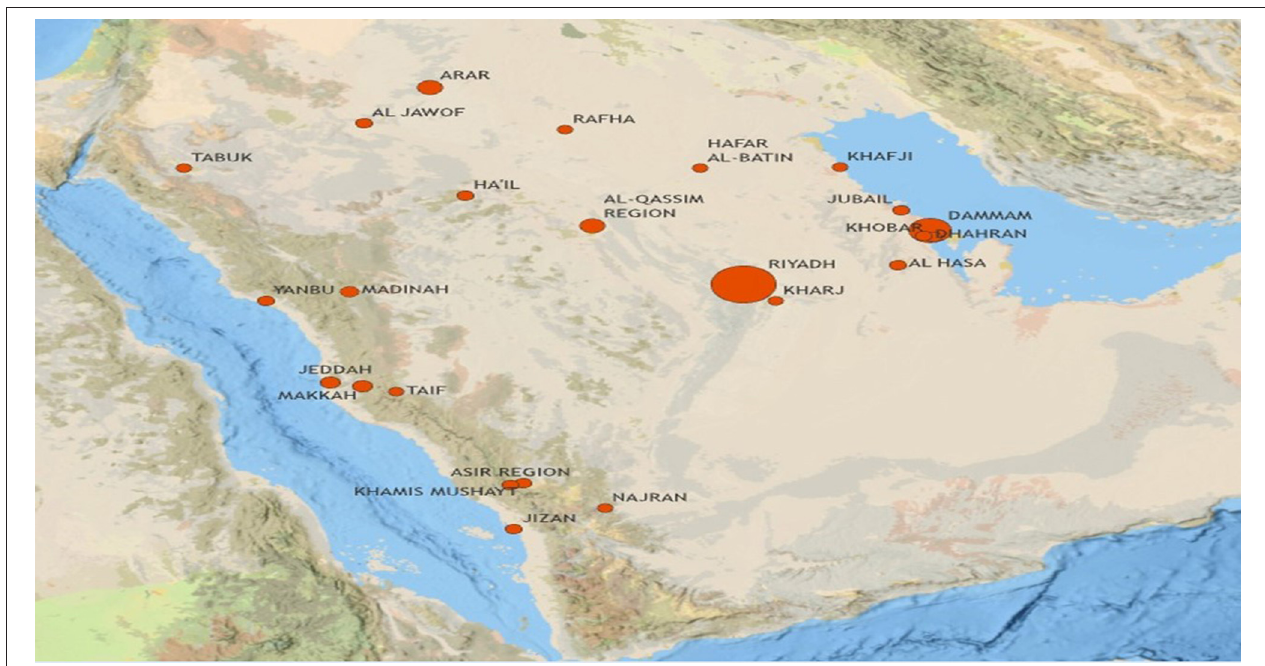
FIGURE 1 | Distribution of study sample across Saudi Arabia.